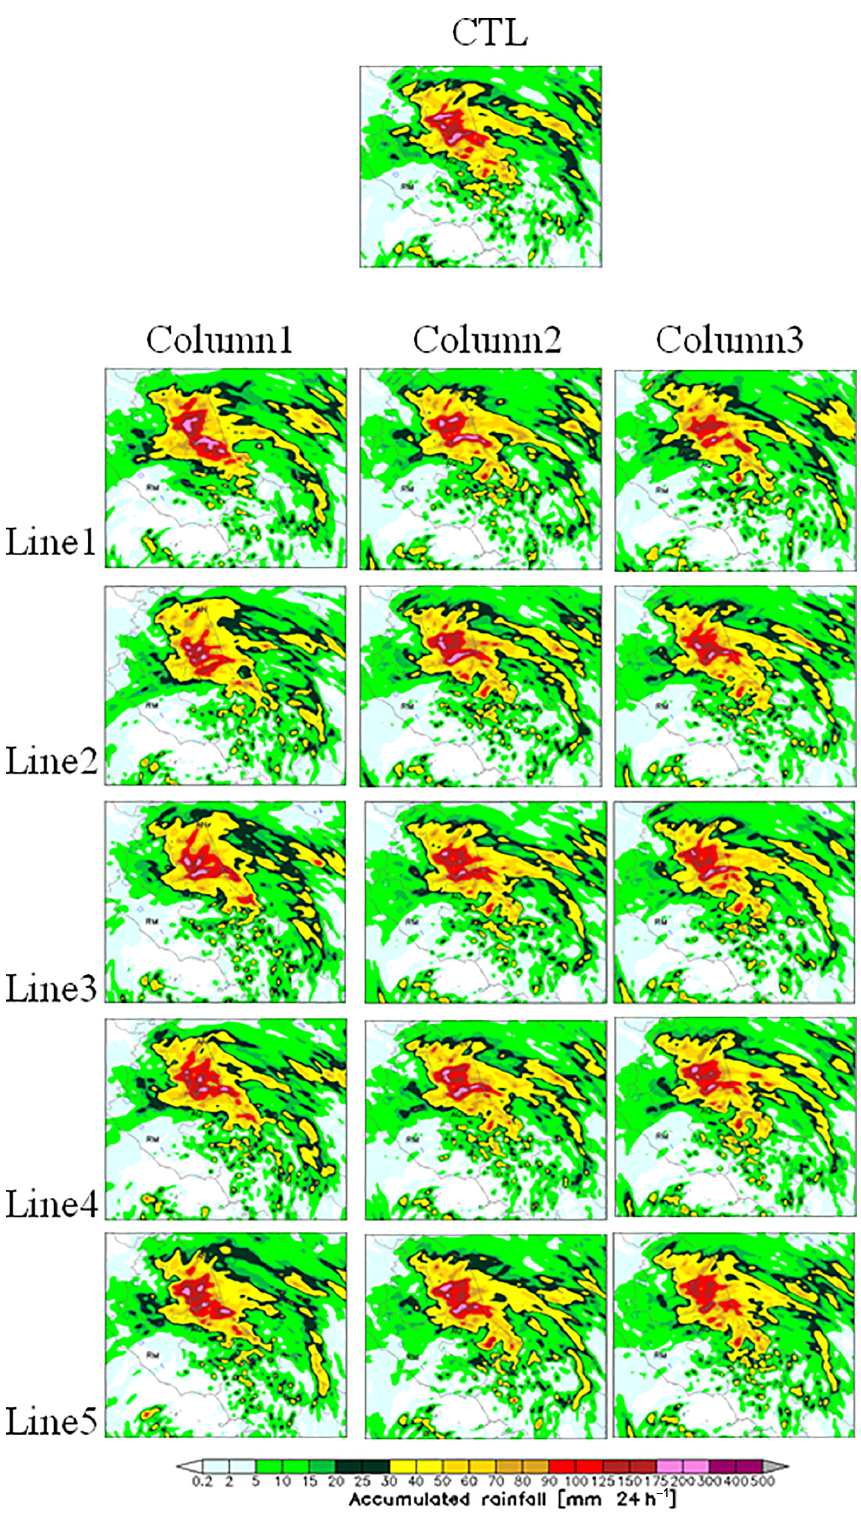
Figure 7. WRF D02 accumulated 24h rainfall forecast over central Italy from 00:00UTC on 14 September 2012: CTL simulation (top cen- tre); on each column are simulations obtained performing reflectivity assimilation at different resolutions (*12KM, *3KM, *12KM_3KM); on each line are simulations performed assimilating different kinds of data (CON*, CONMM*, CONMMPOL*,CONMMPOLSPC*, CON-